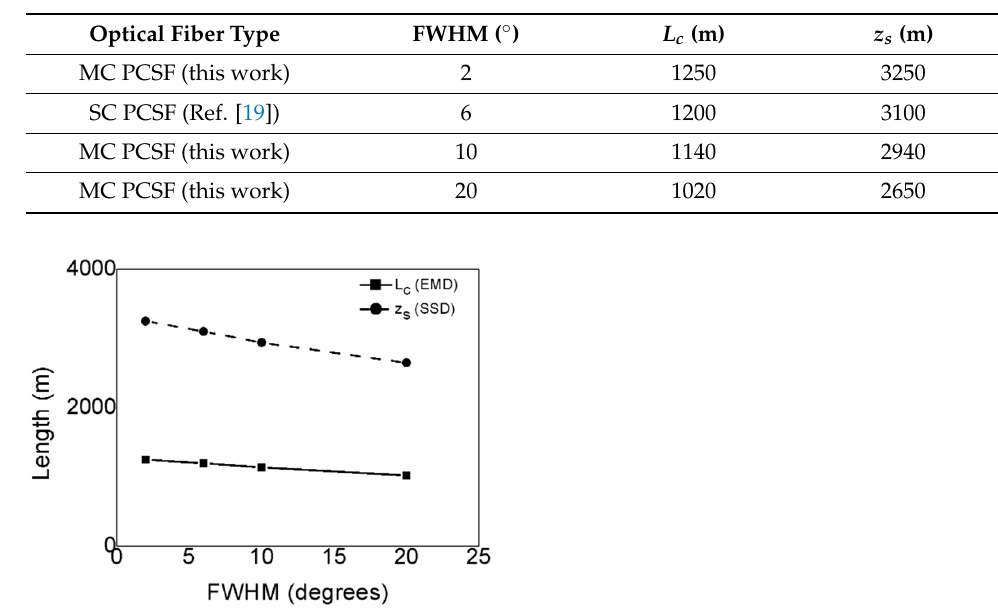
Table 1. Coupling length L c for obtaining the EMD and length z s for establishing an SSD in each of seven cores of MC PCSF for varying FWHM of the launch beam distribution. The case of SC PCSF previously investigated in Ref. [19] is included for comparison.